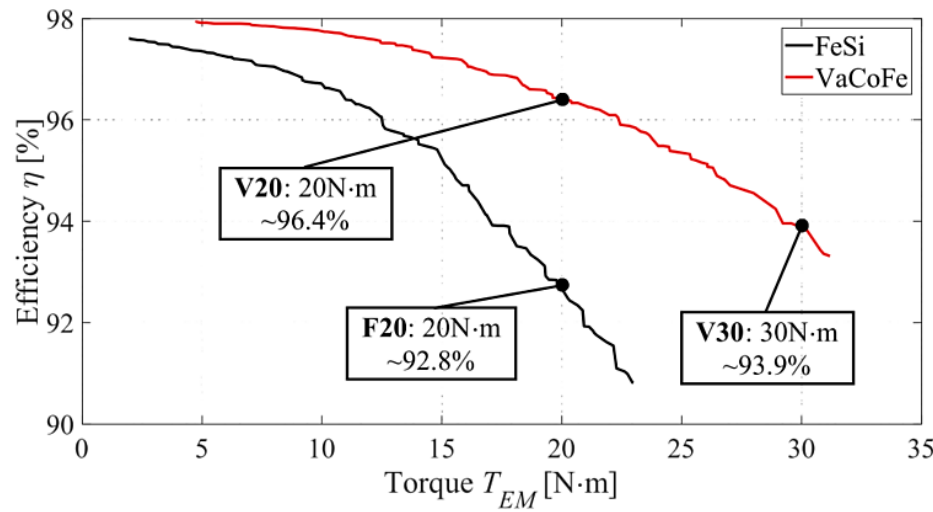
Figure 9. Optimization results present the efficiency as a function of the torque for the FeSi and CoFe PMSMs [22].